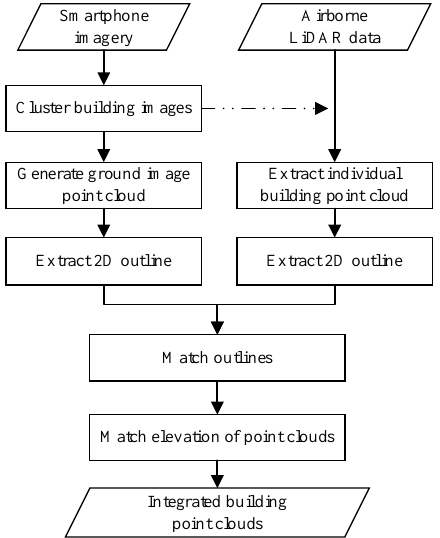
Figure 1. Workflow for the integration of airborne LiDAR data and ground smartphone